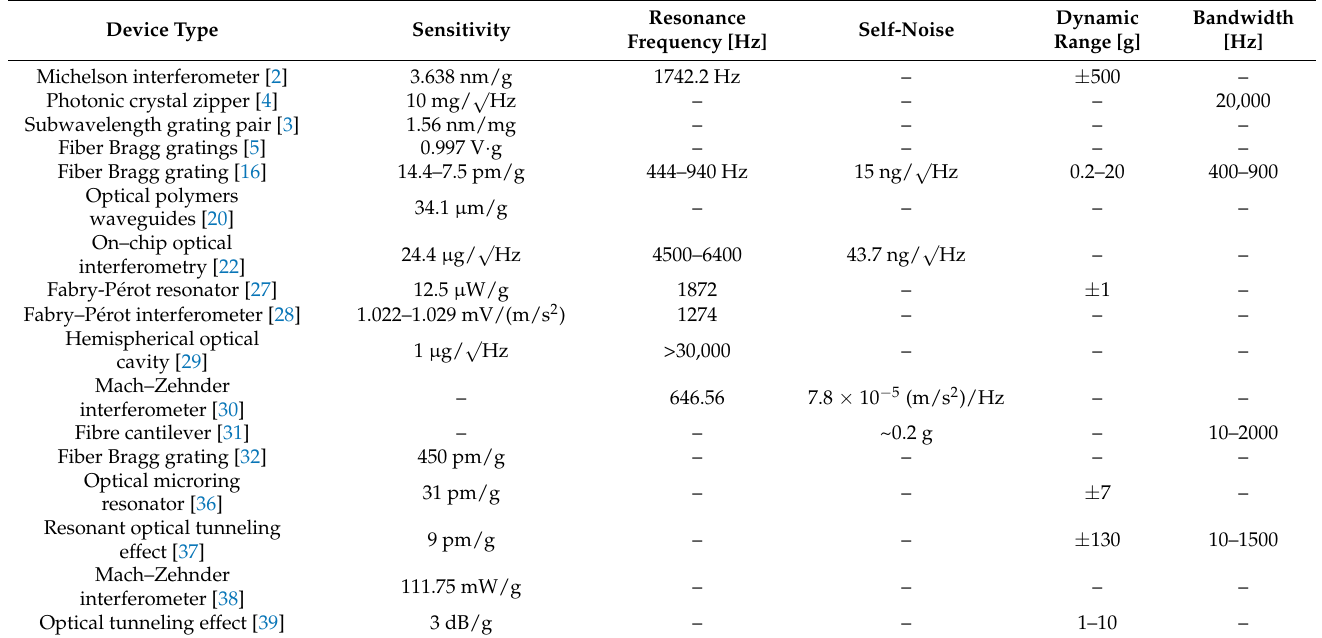
Table 1. Summarized literature review.